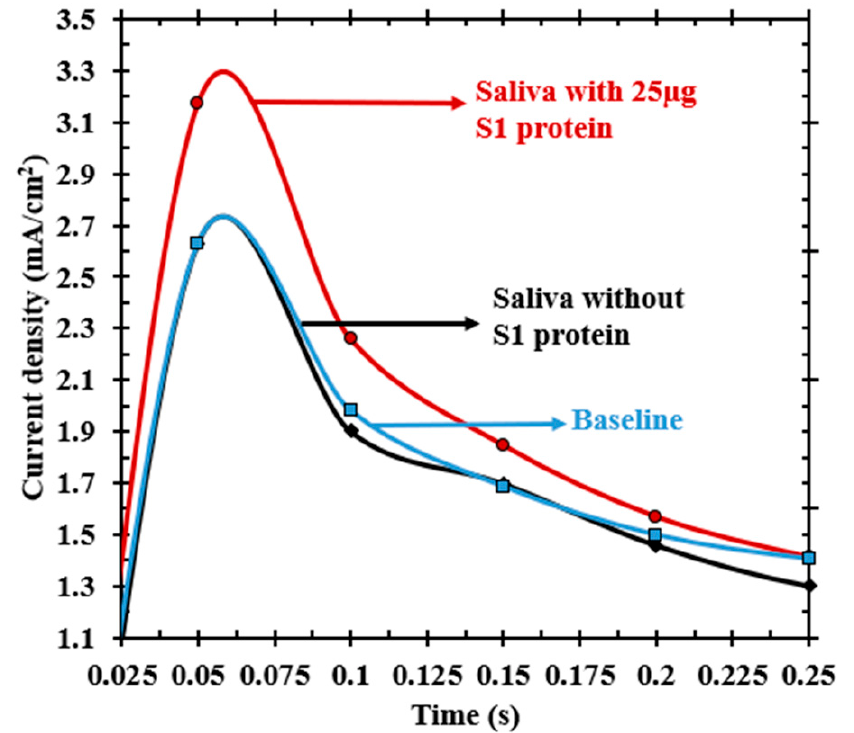
Figure 6. Plot of current density as a function of time showing that the human saliva sample without SARS-CoV-2 S1 protein overlapped with the baseline KOH solution indicating that there was no interference from a SARS-CoV-2 negative sample. The SARS-CoV-2 negative sample spiked with SARS-CoV-2 S1 protein showed an electric current higher than the baseline or negative sample, proving the detection of the S1 protein in human saliva